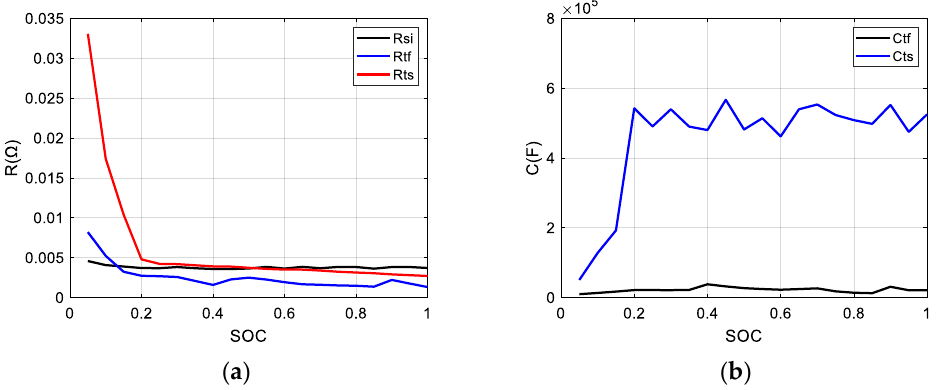
Figure 5. Result of parameter identification. ( a ) The value of the resistance. ( b ) The value of the capacitor.